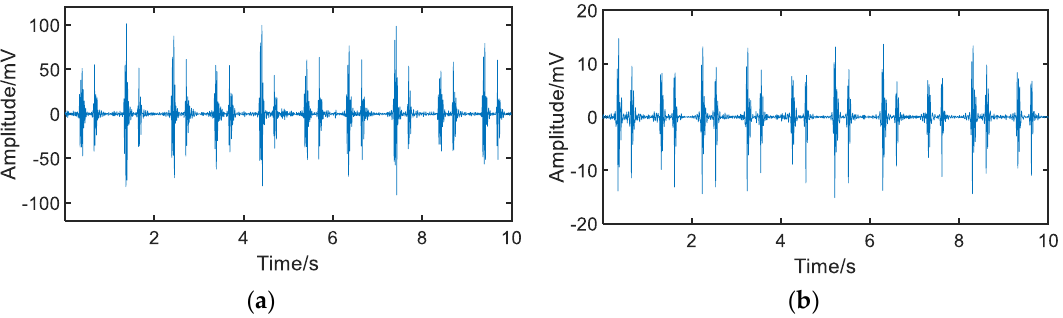
Figure 9. Heart sound signals acquired by the two sensors from the same area on the chest surface. ( a ) heart sound signal acquired by the novel sensor; ( b ) heart sound signal acquired by the ADInstruments sensor.